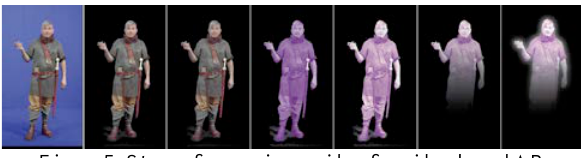
Figure 5. Steps of preparing a video for video-based AR (Dastageeri et. al.,